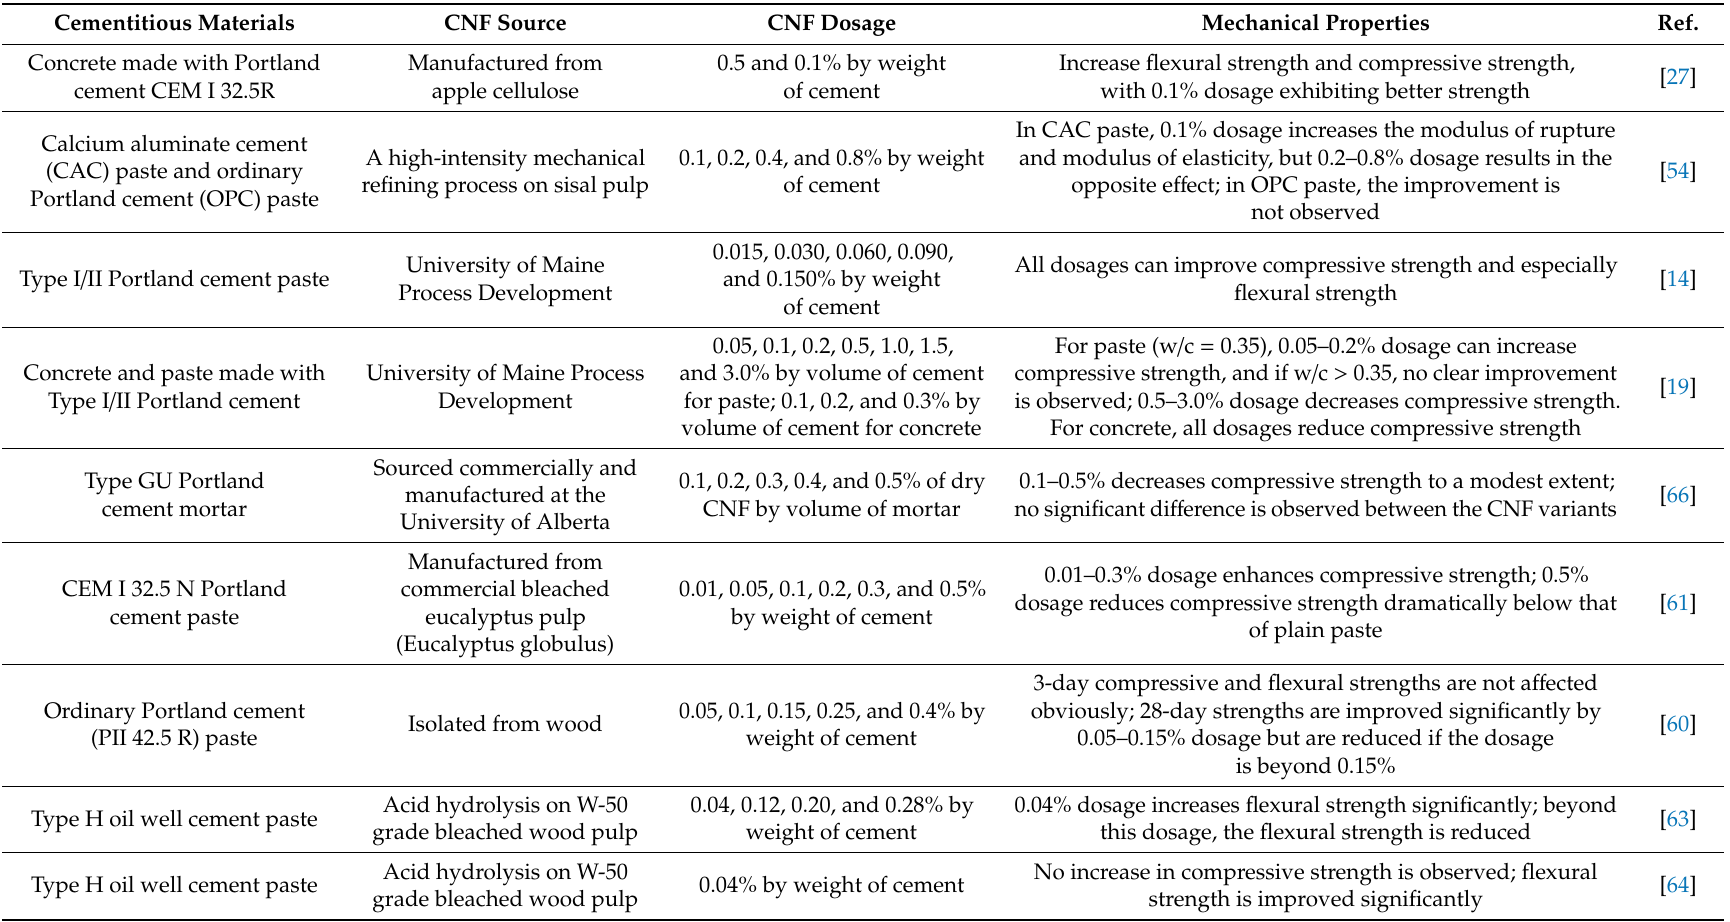
Table 2. Mechanical properties of cementitious materials with